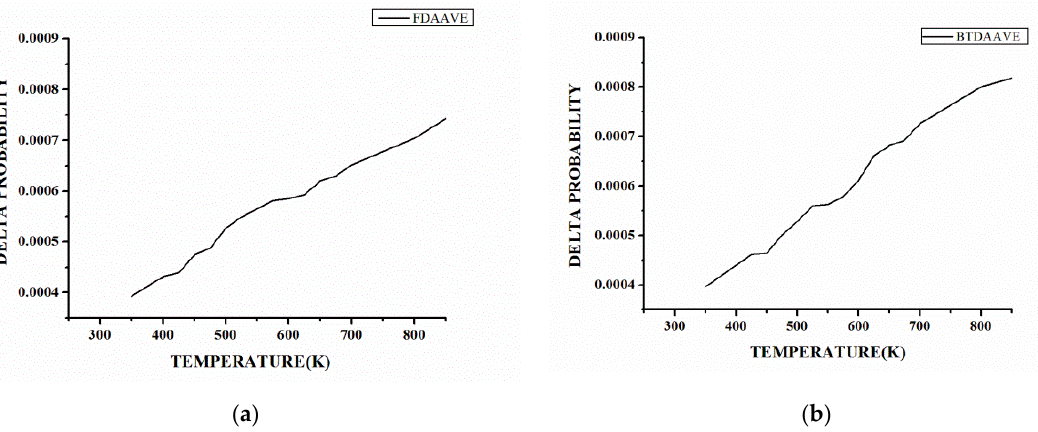
Figure 8. Temperature variation in the dihedral angle distribution in the main chain structure: ( a ) 6FDA-APB, and ( b )